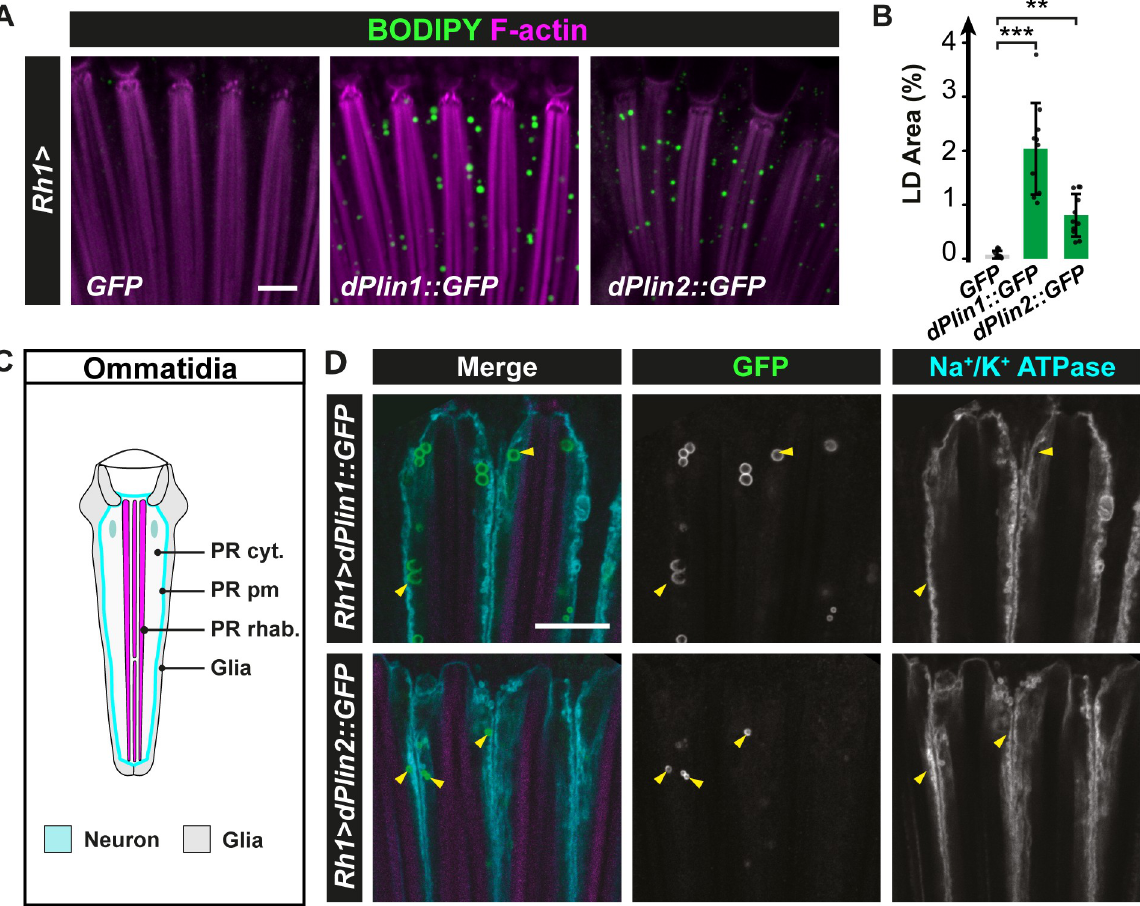
Fig 1. dPlin1 and dPlin2 promote LD accumulation in Drosophila photoreceptor neurons. (A) LD staining of whole-mount retinas from flies expressing GFP (control), dPlin1::GFP, or dPlin2::GFP in photoreceptor neurons ( Rh1-GAL4 ). LDs are in green (BODIPY) and photoreceptor rhabdomeres are in magenta (phalloidin-rhodamine). Scale bar, 10 μ m. (B) Quantification of LD area expressed as % of total retinal area. Data are from the images shown in (A). Mean ± SD. ��� p < 0.001 by ANOVA with Tukey’s HSD test. (C) Diagram of a longitudinal section of one ommatidium. Each ommatidium is composed of 8 photoreceptor neurons delimitated by a Na + /K + ATPase positive plasma membrane (cyan), each containing one rhabdomere (magenta), and surrounded by 9 glial cells (also known as retinal pigment cells; light gray). (D) Immunostaining of whole-mount retinas from flies expressing dPlin1::GFP or dPlin2::GFP in photoreceptor neurons ( Rh1-GAL4 ). Photoreceptor plasma membranes are in cyan (anti-Na + /K + ATPase) and rhabdomeres are in magenta (phalloidin-rhodamine). dPlin1 and dPlin2 are visible as ring shapes in the photoreceptor cytoplasm (yellow arrowheads). Scale bar, 10 μ m.